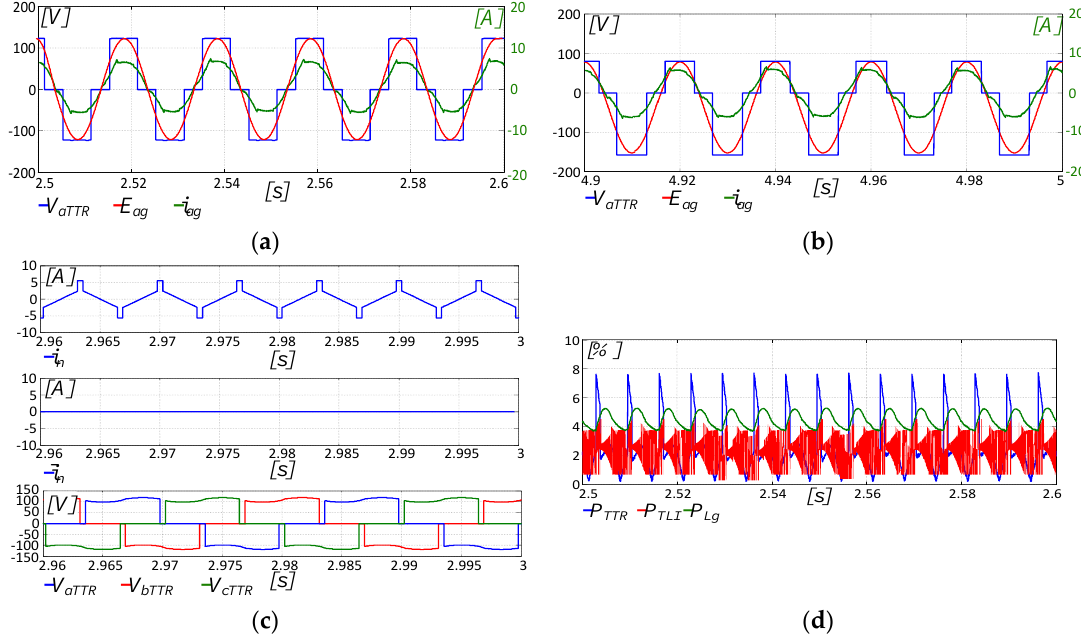
Figure 15. SimPower System model. ( a ) Balanced DC bus capacitor voltage operations, V aTTR , E ag , and i ag . ( b ) Unbalanced DC bus capacitor voltage operations. ( c ) Current i n , average value 𝑖̅ 𝑛 , and AC input Vienna voltages V iTTR . ( d ) TRR power losses P TTR , TLI power losses P TLI , and PMSG power losses P Lg .